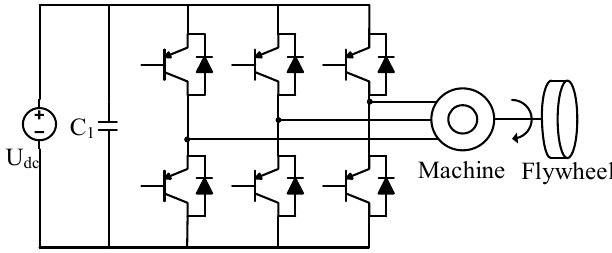
Figure 25. Topology of full-bridge inverter with flywheel.